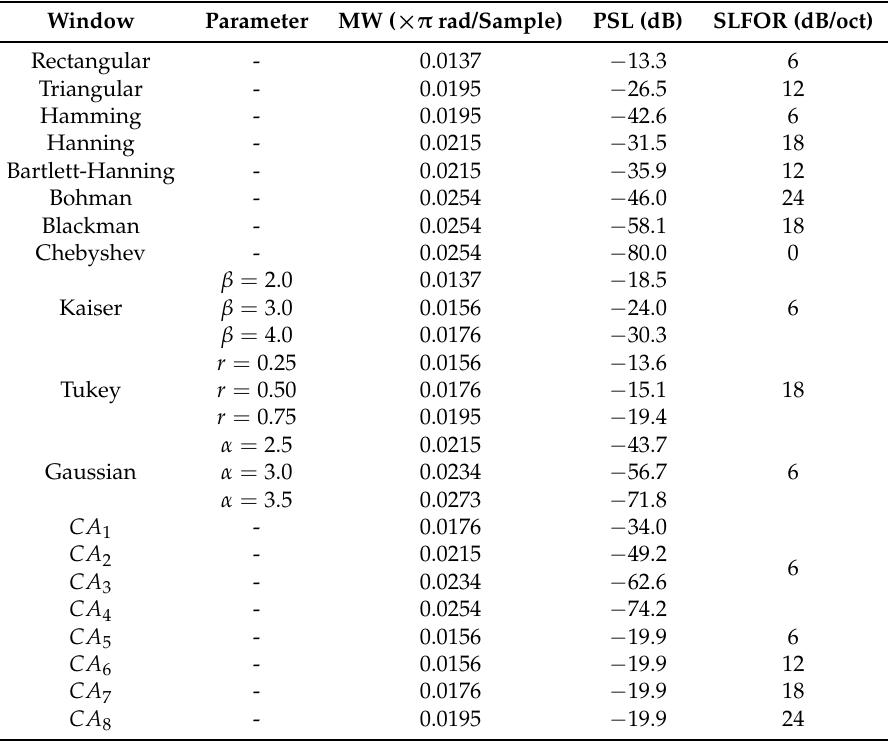
Table 1. Property